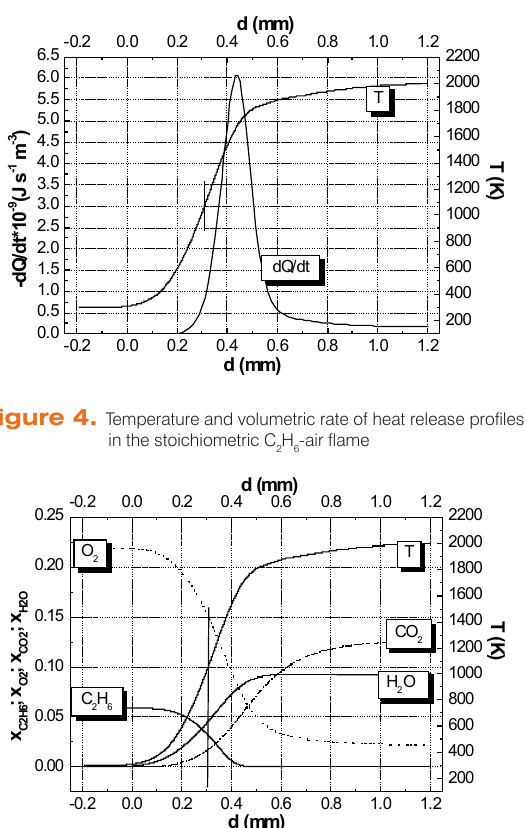
Figure 6. Temperature and mass fractions of intermediates in the stoichiometric C H -air flame at p = 1 bar and 2 6 0 T = 298 K. (a) Profiles of temperature and mass fractions 0 of molecular intermediates; (b) Profiles of temperature and mass fractions of several radical